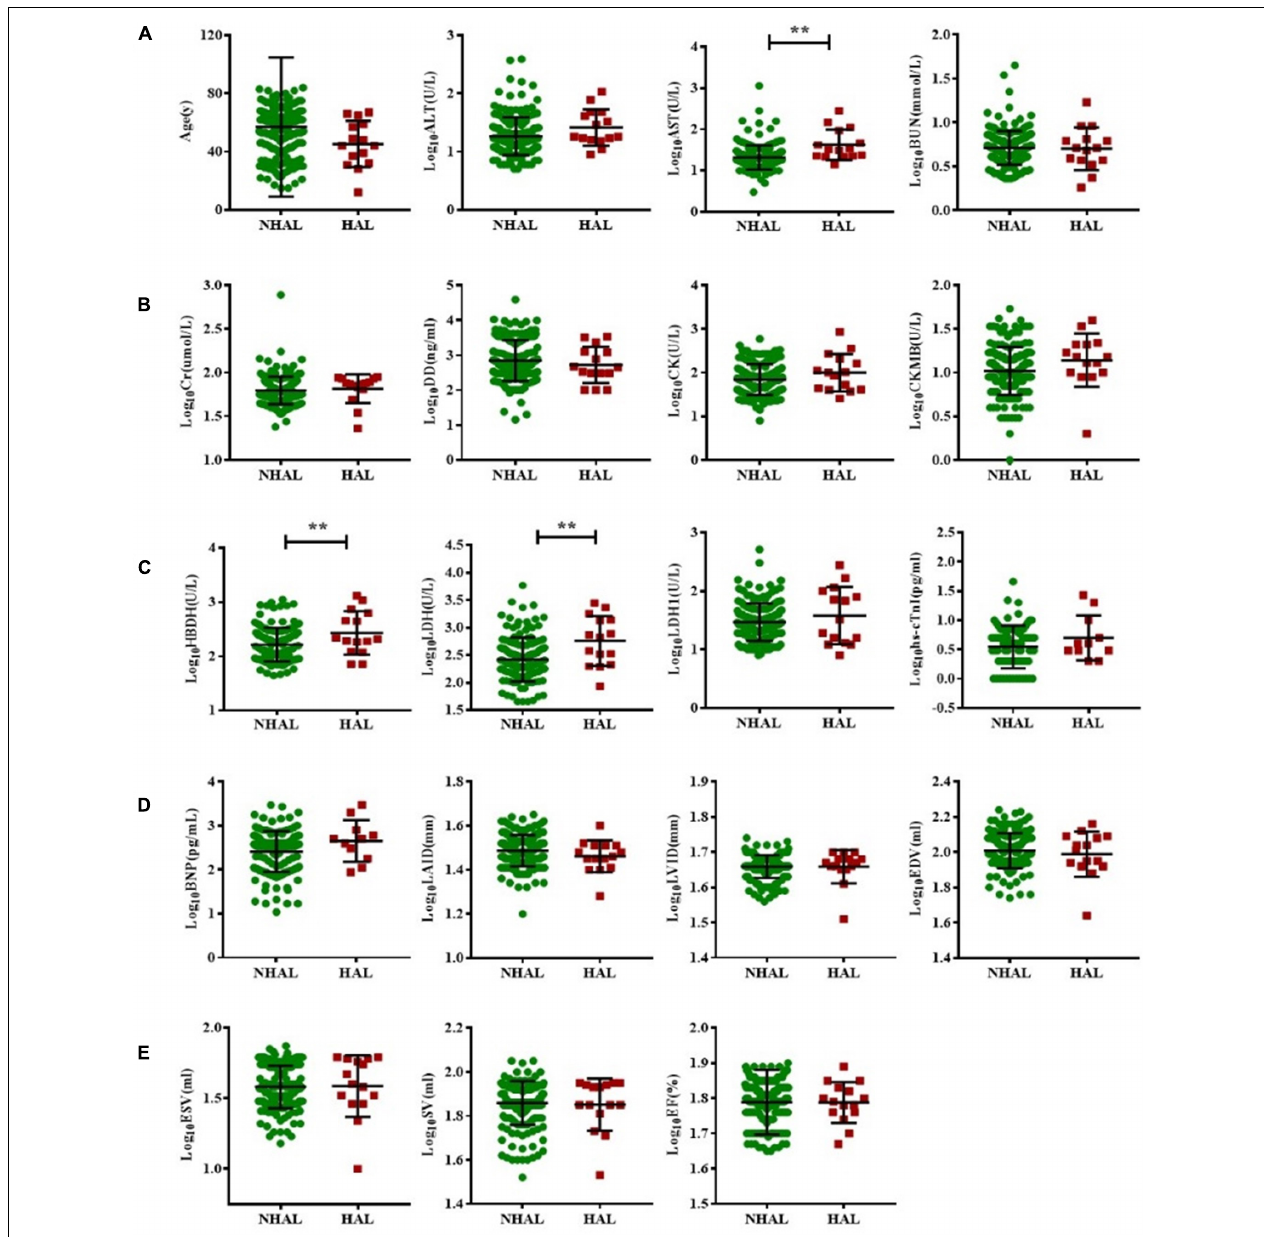
FIGURE 3 | Subgroup analysis of non-hyperleukocytic and hyperleukocytic acute leukemia groups. The T test was used to compare BNP and myocardial enzyme and echocardiography indexes between the NHAL HAL groups (A–E) . (** represents p < 0.01). AST, aspartate transaminase; ALT, alanine aminotransferase; BNP, B-type natriuretic peptide; BUN, blood urea nitrogen; Cr, creatinine; CK, creatine kinase; CK-MB, creatine kinase myocardial band; DD, D-dimer; EDV, end-diastolic volume; ESV, end-systolic volume; EF, ejection fraction; hs-cTnI, highly sensitive troponin-I; HBDH, hydroxybutyrate dehydrogenase; HAL, hyperleukocytic acute leukemia; IVS, interventricular septal; LVPW, left ventricular posterior wall; LDH, lactate dehydrogenase; LAID, left atrial internal diameter; LVID, left ventricular internal diameter; NHAL, non-hyperleukocytic acute leukemia; SV, stroke